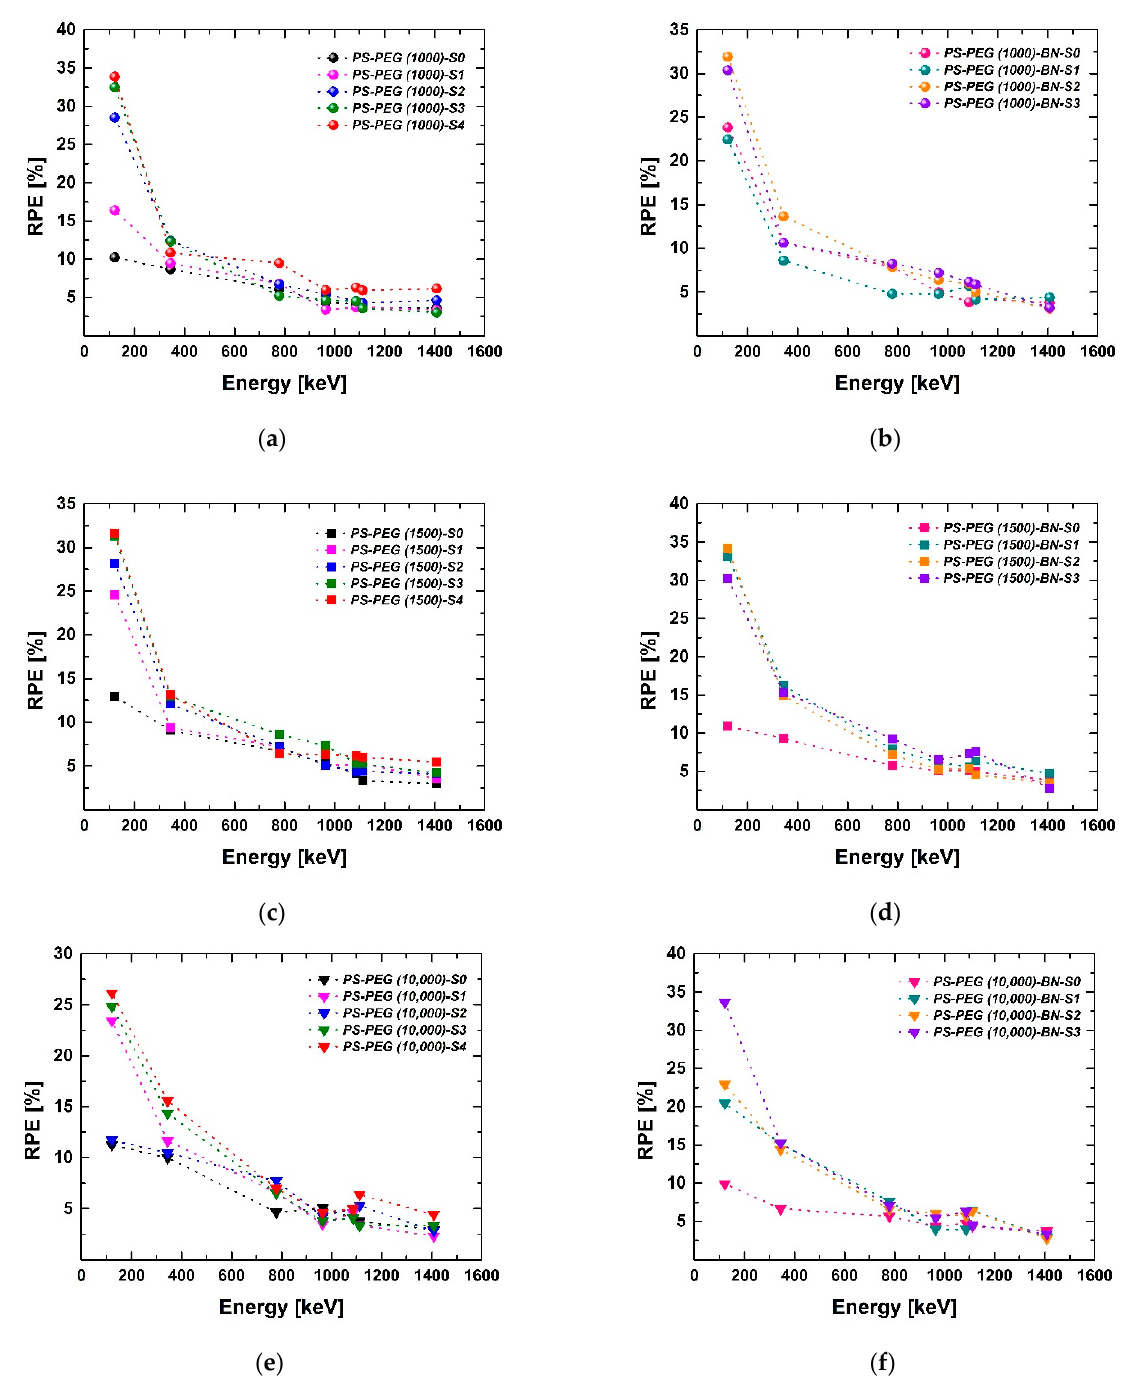
Figure 11. The RPE values of the PbO doped the crosslinked PS-b-PEG block copolymers and the PbO doped the PS-b-PEG-BN nanocomposite materials at different gamma radiation energies (from 121.782 keV to 1408.006 keV) of 152 Eu : ( a ) PS-PEG (1000)-S0,S1,S2,S3,S4; ( b ) PS-PEG (1000)-BN-S0,S1,S2,S3; ( c ) PS-PEG (1500)-S0,S1,S2,S3,S4; ( d ) PS-PEG (1500)-BN-S0,S1,S2,S3; ( e ) PS-PEG (10,000)-S0,S1,S2,S3,S4; ( f ) PS-PEG (10,000)-BN-S0,S1,S2,S3.